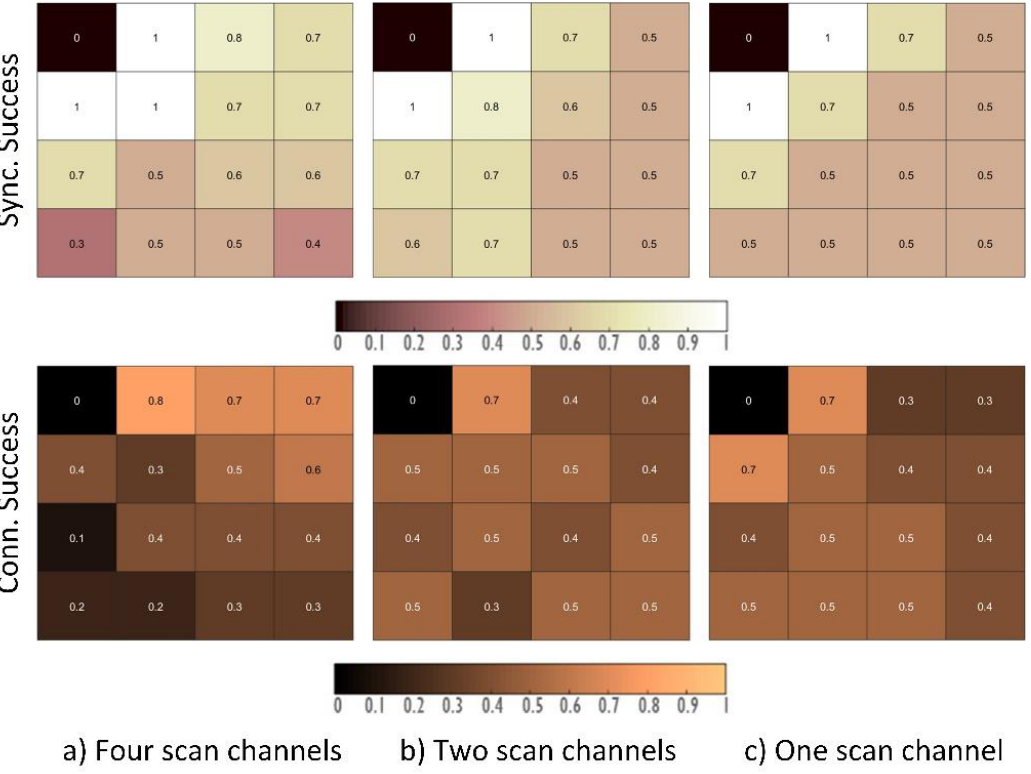
Figure 9. The probability of synchronization and connection success for different numbers of scan channels.